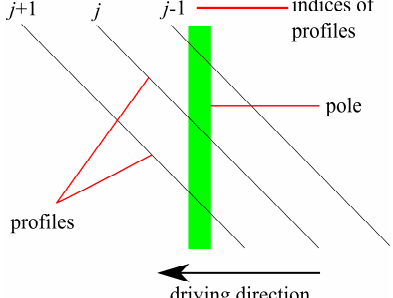
Figure 3. Scanning geometry of Roamer when backwards tilted scanning plane is used. Even narrow pole-like objects receive several hits from neighbouring profiles. The scan line structure of the data is utilised in the segmentation process by searching short point groups that are on top of each other in neighbouring profiles. (modified from (Kukko,